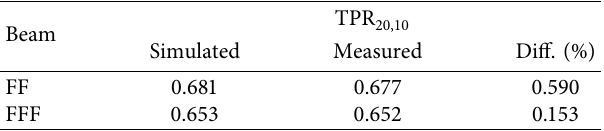
Table 3: The simulated and measured beam qualities of the FF beam and FFF beam are shown. The uncertainties of the simulated beam qualities of FF and FFF beam were 0.6% and 0.7% (coverage factor k � 2),